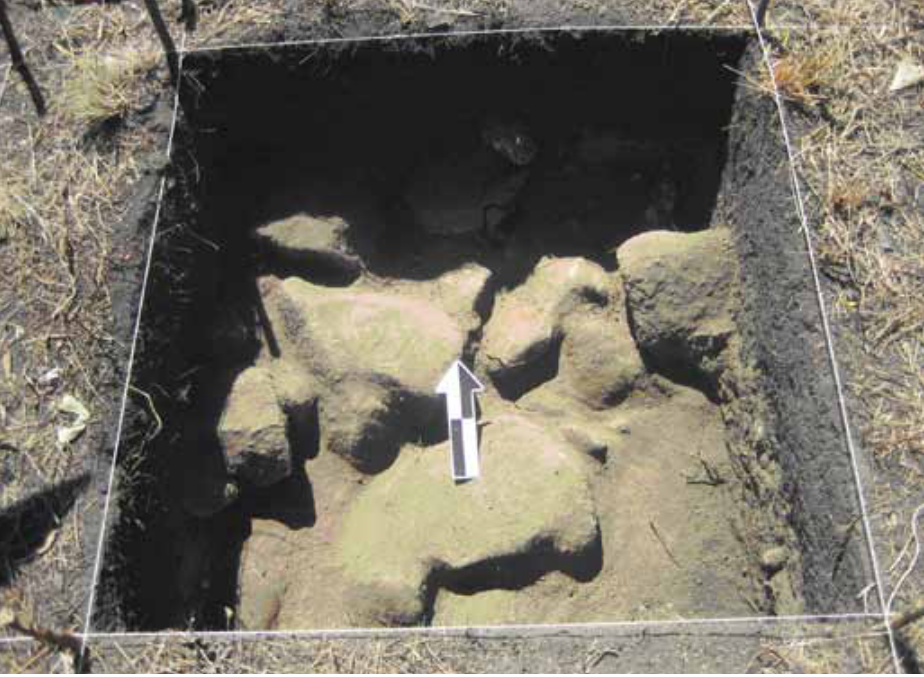
Fig 4: The floor of Nundu (ST1) Unit